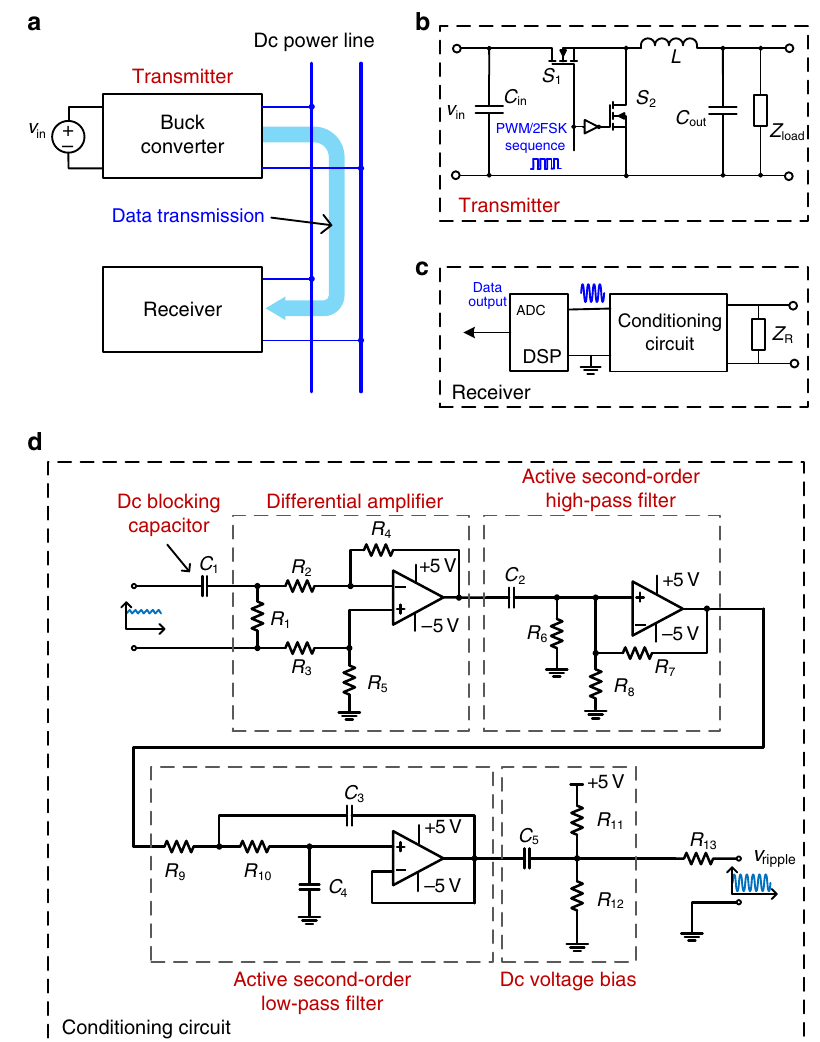
Fig. 7 The structure of the prototype used in the basic validation experiment. a The general structure of the prototype. It includes a buck/boost converter as a data transmitter and a receiver sharing a common power line with the buck/boost converter. v in denotes the input voltage of the buck converter. Data are transmitted from the buck/boost converter to the receiver via the dc power line. b Detailed circuit of the buck/boost converter, in which v in denotes the input voltage, C in denotes the input capacitor while C out denote the output capacitor. L denotes the inductor and Z load denotes the load. The modulated signal is the gate signal for MOSFET S 1 , and its complementary signal is the gate signal for MOSFET S 2 . c The structure of the receiver. It consists of load Z R , a signal conditioning circuit and a DSP with analogue-to-digital converter (ADC) to output digital data. d The signal conditioning circuit in the receiver. This circuit is composed of a dc blocking capacitor, a differential ampli fi er, an active second-order high-pass fi lter, an active second- order LPF and a dc voltage bias circuit. R 1 – R 13 denote resistors, and C 1 – C 5 denote capacitors. v ripple denotes the conditioned signal voltage. The input